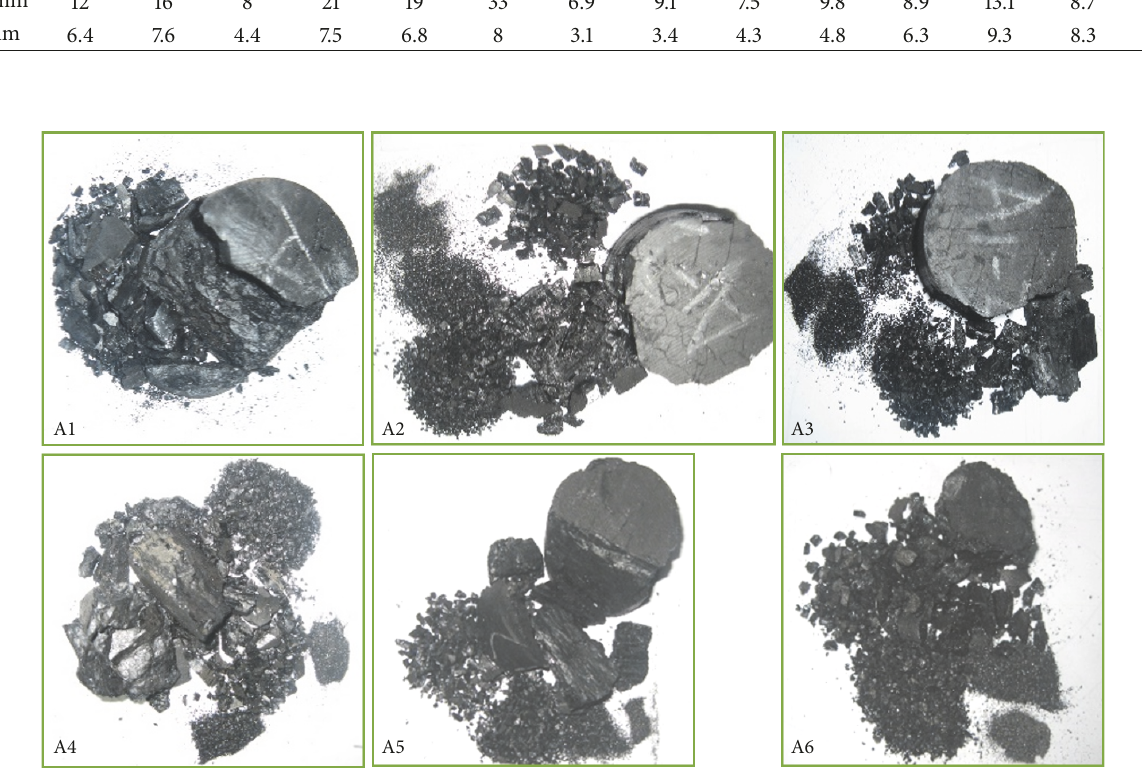
Figure 14: Failure forms of natural and 7D saturated specimens under uniaxial static loads.